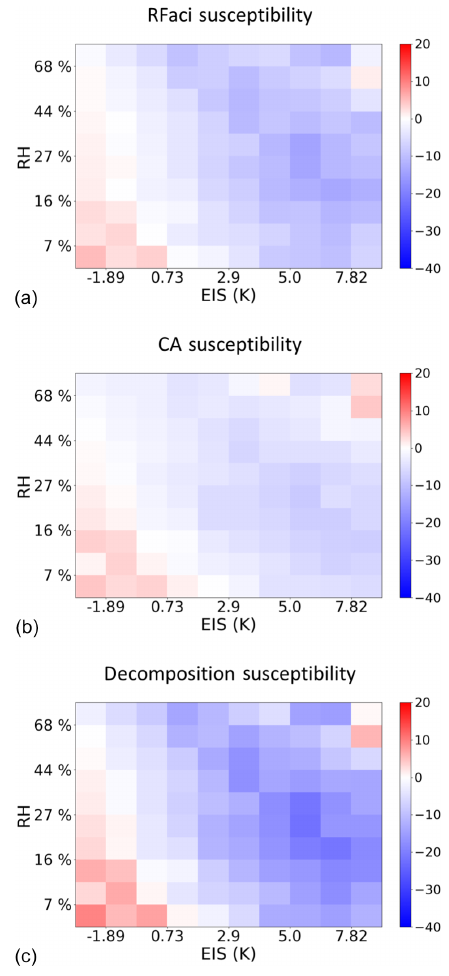
Figure 3. Variations in the (a) RFaci warm susceptibility, − 5 . 26Wm − 2 ln(AI) − 1 , (b) cloud adjustment susceptibility, − 2 . 88Wm − 2 ln(AI) − 1 , and (c) the sum of the two suscep- tibilities, i.e., the decomposed ERFaci warm susceptibility, − 8 . 22Wm − 2 ln(AI) − 1 , with meteorological regimes defined by EIS and RH 700